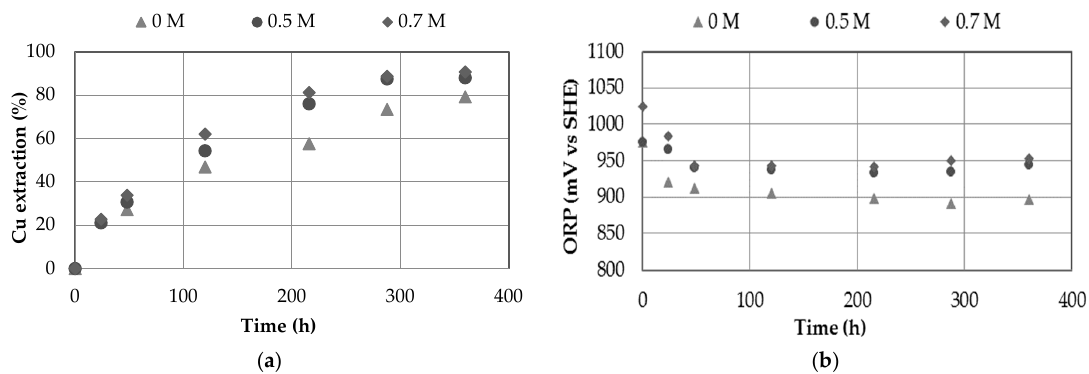
Figure 2. ( a ) Copper extraction (%) vs. time (h) at di ff erent sodium nitrate concentration: 0, 0.5 and 0.7 M. ( b ) Redox potential (mV) vs. time (h) at di ff erent sodium nitrate concentration: 0, 0.5 and 0.7 M. Experimental conditions: [H 2 SO 4 ] = 0.7 M, seawater as a dissolvent, 45 ◦ C and sample A.